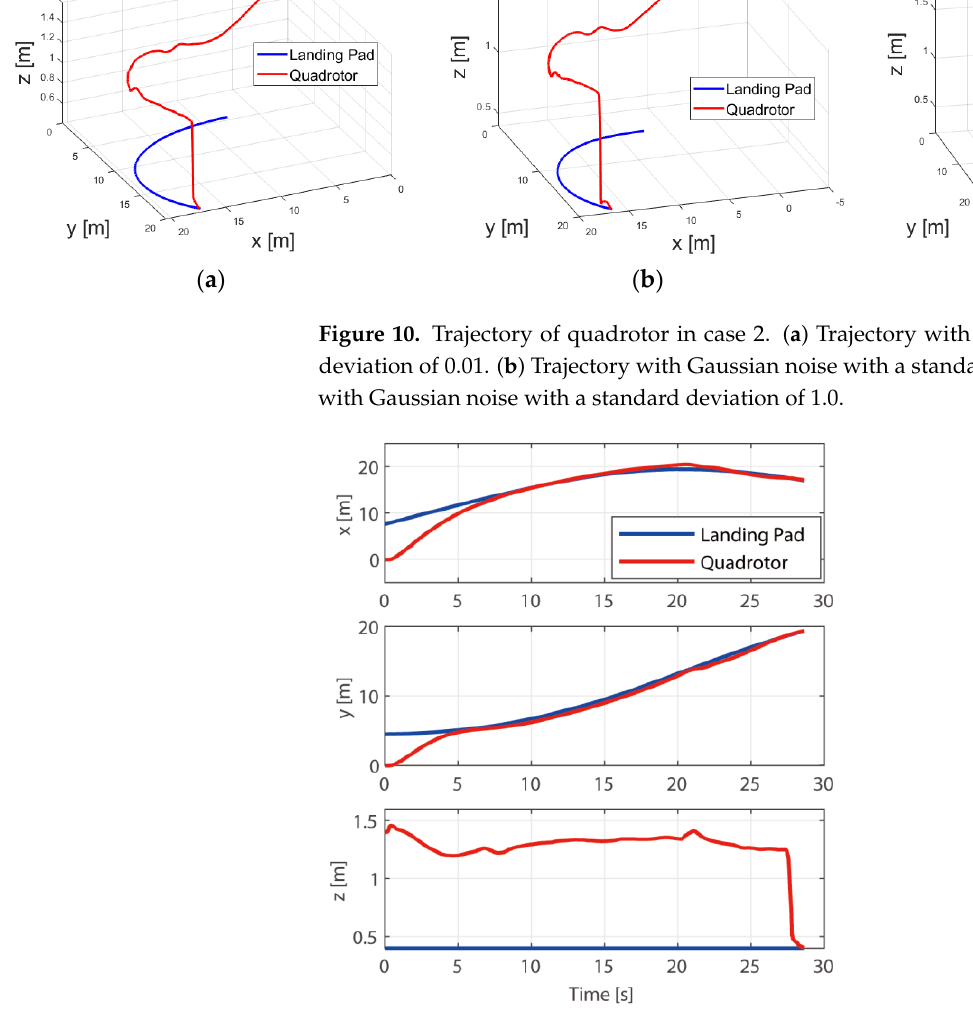
Figure 11. Position of quadrotor and landing pad in case 2.